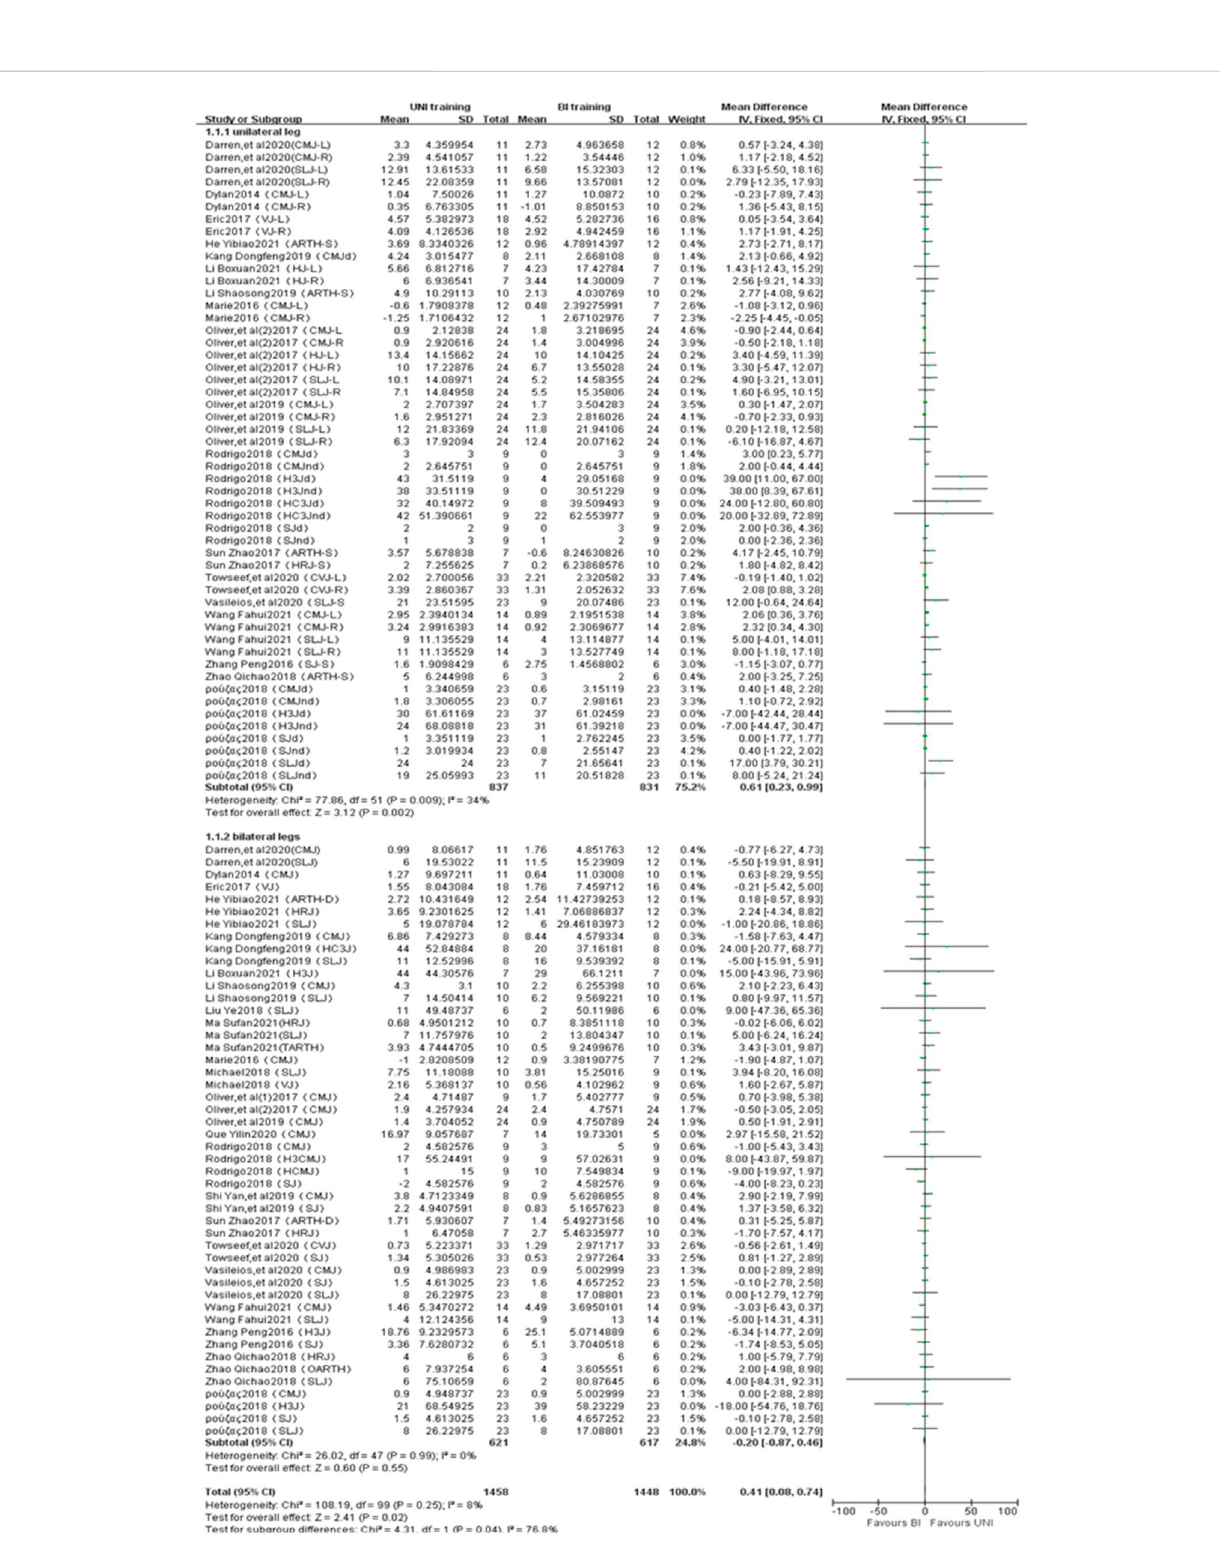
FIGURE 3 Intergroup Forest plots of UNI and BI training affecting jumping ability. CMJ = countermovement jump; CMJ-L = countermovement jump with left leg; CMJ-R = countermovement jump with right leg; CMJd = countermovement jump with dominant leg; CMJnd = countermovement jump with non- dominant leg; CMJ-S = countermovement jump with single leg; SLJ = standing long jump; SLJ-L = standing long jump with left leg; SLJ-R = standing long jump with right leg; SLJd = standing long jump with dominant leg; SLJnd = standing long jump with non-dominant leg; SLJ-S = standing long jump with single leg; VJ = vertical jump; VJ-L = vertical jump with left leg; VJ-R = vertical jump with right leg; VJd = vertical jump with dominant leg; ARTH-D = assisted running double feet touchhigh; ARTH-S = assisted running single foot touchhigh; HRJ = highestreachjump; HRJ-S = highest reach jump with single leg; HC3J = cross and horizontal triple jump; H3J = horizontal triple jump; H3J-R = horizontal triple jump with right leg; H3Jd = horizontal triple jump with dominant leg; H3Jnd = horizontal triple jump with non-dominant leg; HJ-L = horizontal jump with left leg; HJ-R =